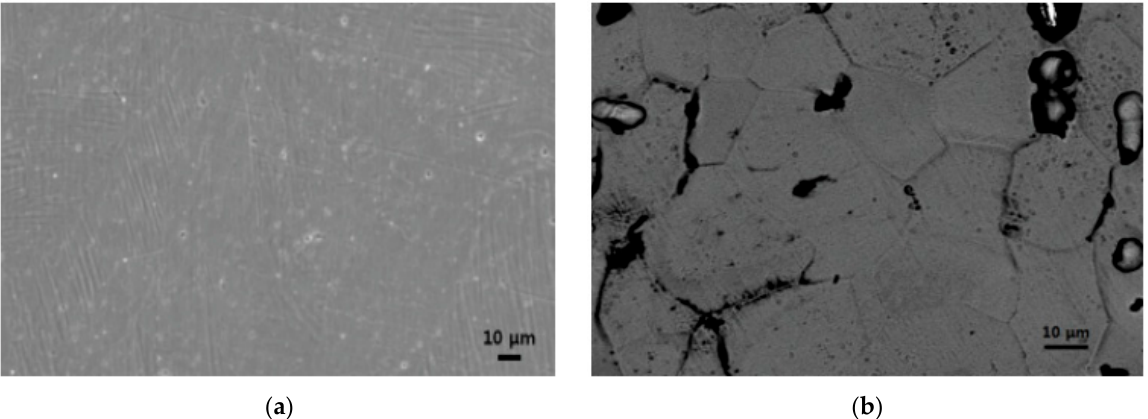
Figure 13. SEM micrographs showing the consolidation of Al-Ti 25 MA powders: ( a ) by EDS with 5 kJ/g, attaining a fine microstructure of bulk Ti 3 Al; ( b ) by conventional sintering at 1250 °C in a vacuum of 2·10 − 7 torr for 2.5 h, attaining a porous microstructure. Reprinted with permission from ref. [47] Copyright 2017 Polska Akademia Nauk.